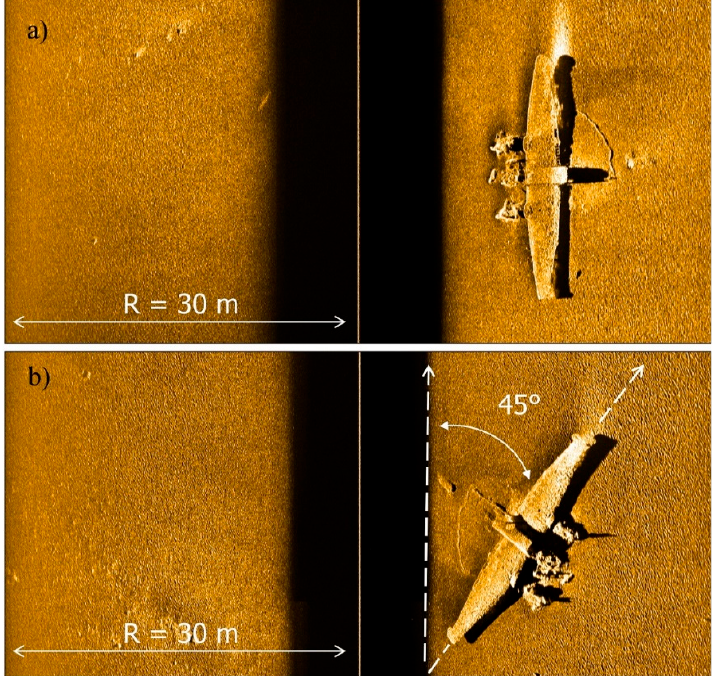
Figure 9. Side scan sonar data recorded with the Klein 3900 system: ( a ) sonar track line parallel to the axis of the airplane wings; ( b ) sonar track line at the angle of 45 degrees to the axis of the airplane wings.